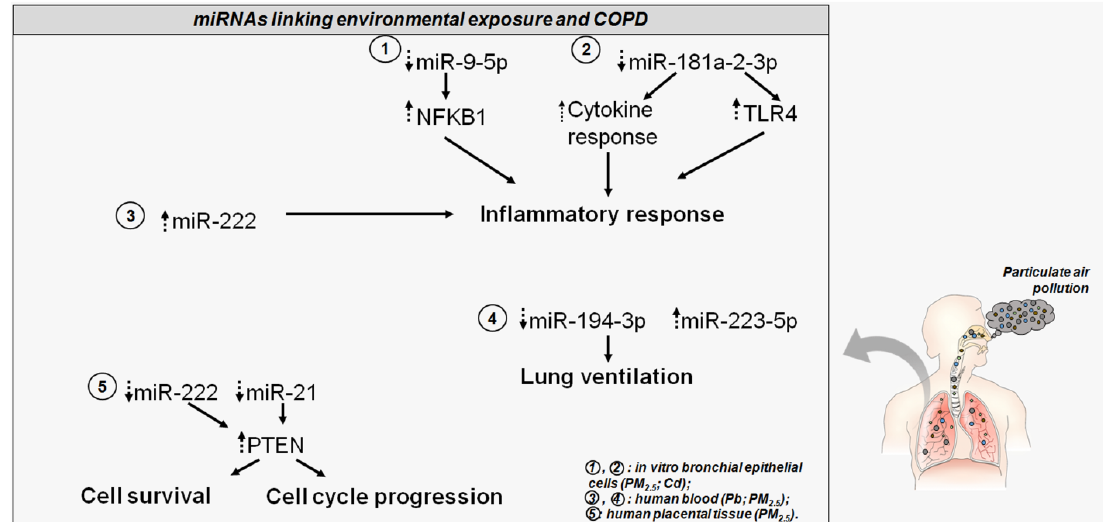
Figure 2. The altered miRNAs disturb COPD-related genes and pathways. Dotted head-up arrows indicate upregulated miRNAs / genes due to pollutant exposure; dotted head-down arrows indicate downregulated miRNAs / genes due to pollutant exposure. Circled numbers in the bottom right legend illustrate, for each miRNA, the pollutant exposure, and the source of miRNA